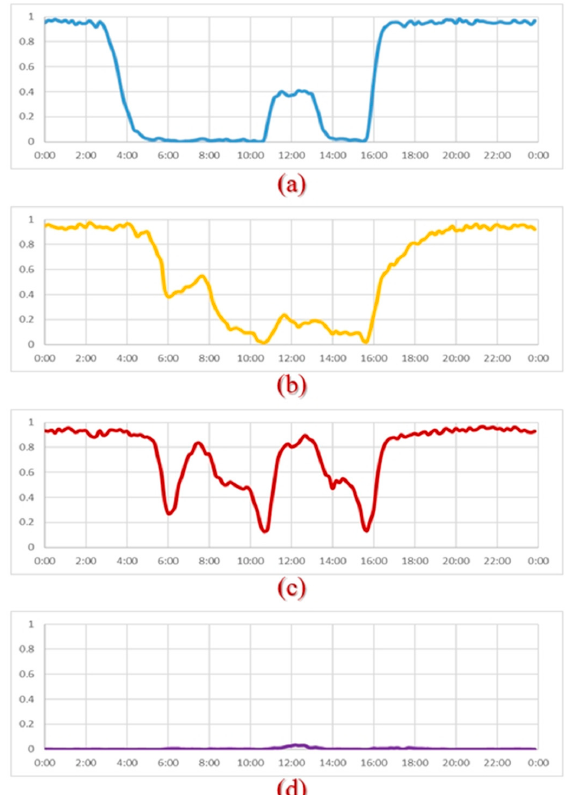
Figure 9. Daily in-bed/off-bed patterns of four types: ( a ) Regular ( b ) Free ( c ) Bedridden ( d ) Leave-home.